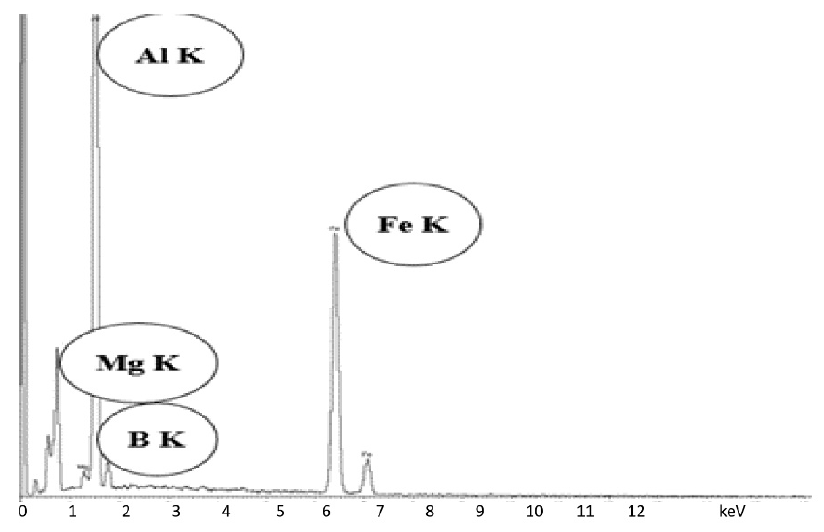
Figure 16. EDX analysis spectrum at point B in specimen welded in inert conditions. Table 12. EDX quantitative analysis data at point B in specimen welded in inert conditions.